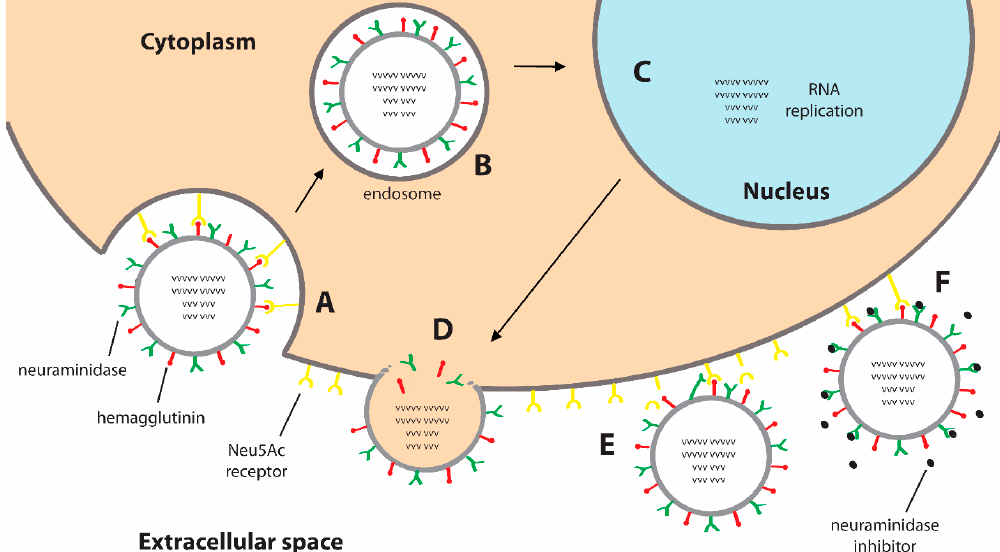
Figure 1. Influenza virus replication pathway and the effect of neuraminidase inhibitors. ( A ) The virus is linked to the host cell via hemagglutinin employing the terminal Neu5Ac residue of the surface receptor. Then, the endocytosis of the virus occurs; ( B ) Viral RNA is released into the cytoplasm where is transferred to the host cell nucleus; ( C ) Viral RNA replication and mRNA synthesis occurs inside the nucleus. The RNA is then released into the cytoplasm; ( D ) Viral proteins are synthetized using mRNA and directed to the cell membrane for virus assembly. After incorporation of the genome fragments, virus budding begins; ( E ) After budding, the virus surface is attached at the Neu5Ac receptor. The neuraminidase is able to hydrolyze Neu5Ac allowing the release of the virus; ( F ) Neuraminidase activity is inhibited in presence of neuraminidase inhibitors preventing the release of the virus and reducing pathogenicity.